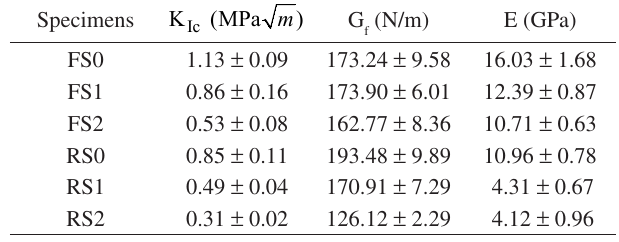
Table 2. Polymer mortar made with raw materials fracture test results (Avg. ±